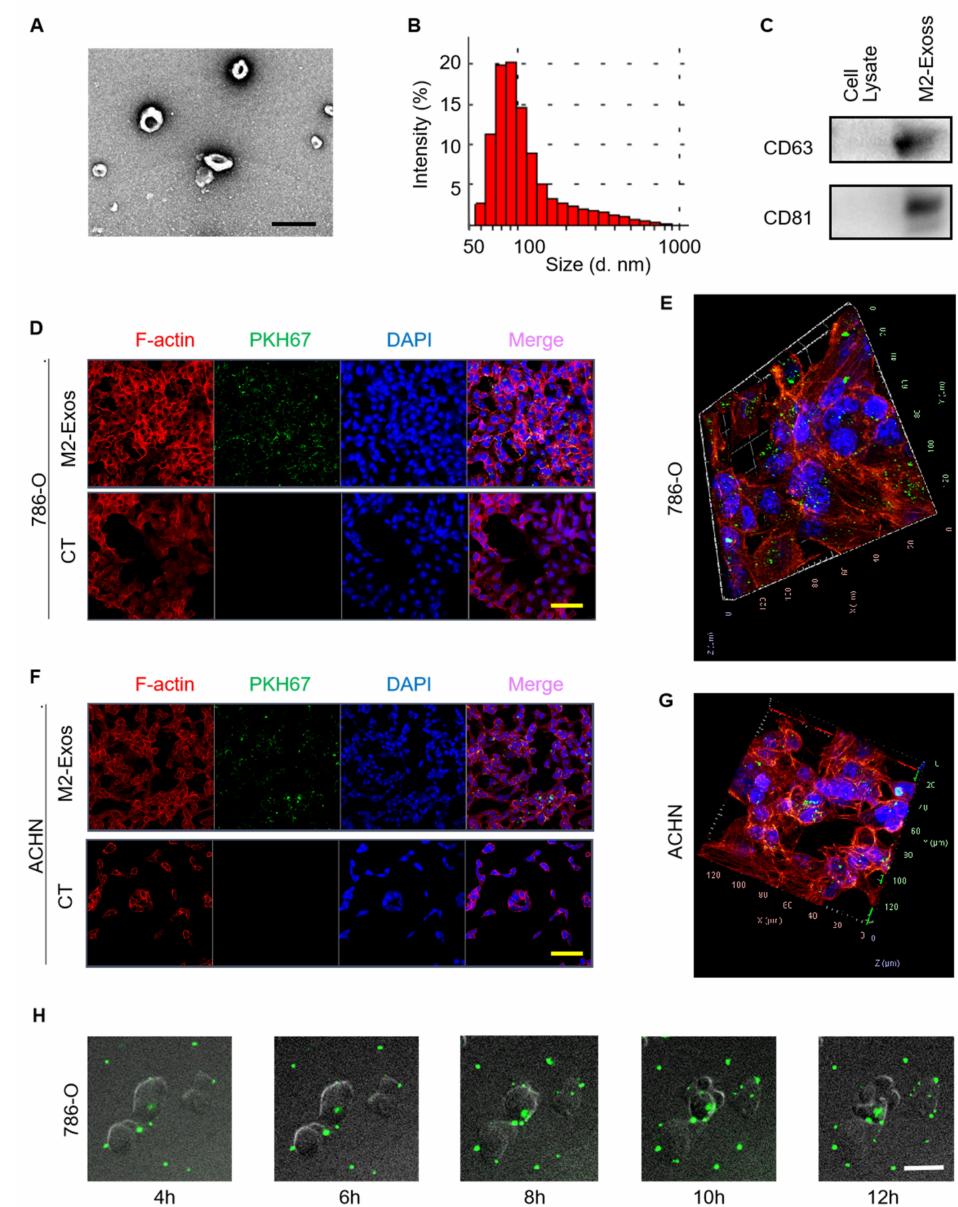
Figure 2. Characterization and internalization of M2-Exos. ( A ) TEM image of M2-Exos. Scale bar: 200nm. ( B ) DLS measurement of M2-Exos size. ( C ) Western blotting assay of exoso- mal markers in THP-1-M2 cellular lysate and M2-Exos preparation. ( D , F ) Fluorescence images of 786-O and ACHN cells treated with or without PKH67-labeled M2-Exos (green). Scale bar: 50 µ m. ( E , G ) Three-dimensional confocal reconstruction of 786-O and ACHN cells treated with PKH67- labeled M2-Exos (green). ( H ) Fluorescence staining analyzing the internalization of M2-Exos by 786-O cells over 12 h. Scale bar: 10 µ m. CT: